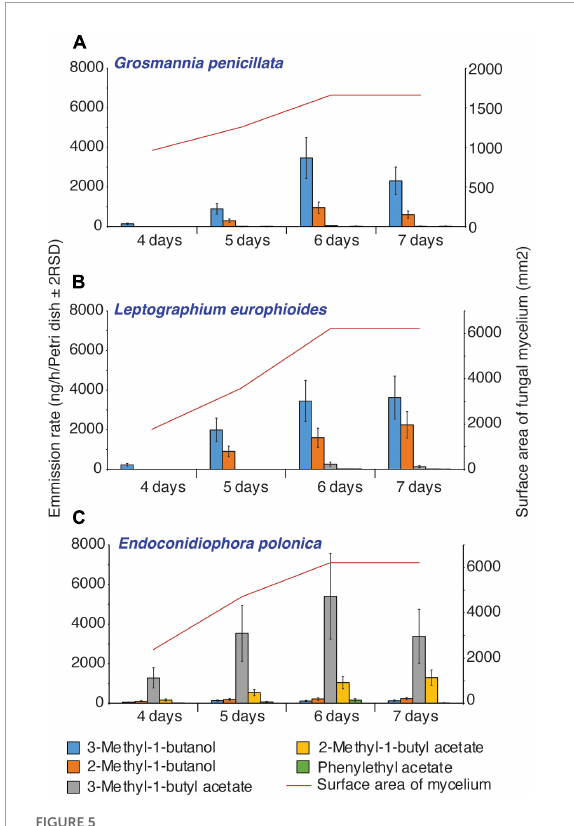
FIGURE5 Emission rate of fusel alcohols and their acetates from perforated Petri dish dispensers inoculated with different fungi in relation to the surface area of fungal mycelium at the time of sampling. Error bars represent relative standard deviation (2RSD) (Ep, day 5, n =